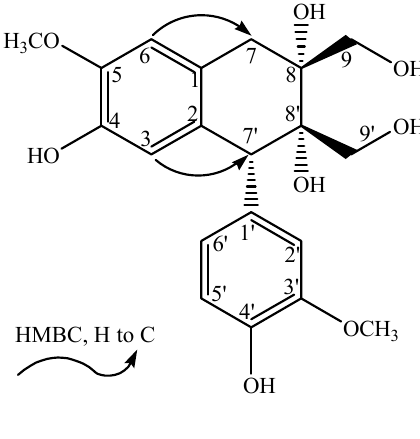
Figure 2. The key correlations of compound 2